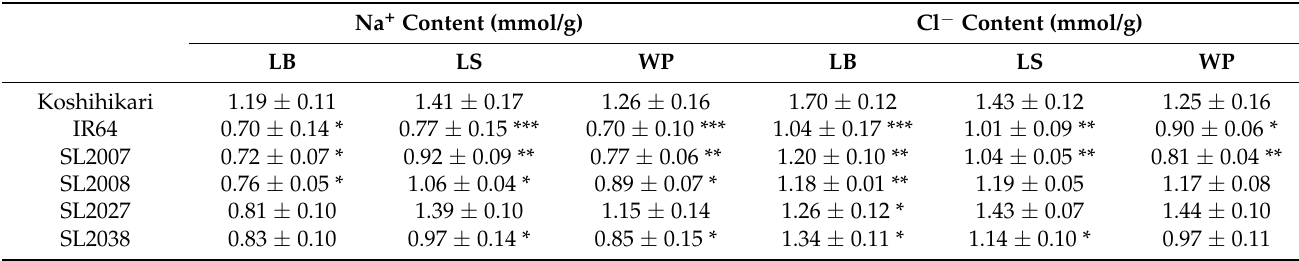
Figure 4. ( A ) Plant dry weight, ( B ) panicle weight, ( C ) panicle number, ( D ) grain yield, ( E ) spikelet number per panicle, ( F ) grain filling, and ( G ) 1000-grain weight of SL2007, SL2008, SL2027, SL2038, Koshihikari, and IR64 under non-stress and stress conditions in 2015. White bars and black bars denote plant performance under non-stress and stress conditions, respectively. Values are mean ± standard error (n = 4). *, **, and *** indicate significant differences from Koshihikari under the non-stress or salt stress condition at the 5%, 1%, and 0.1% levels by Dunnett’s test, respectively. Table 1. Na + and Cl − contents in the leaf blade, leaf sheath, and whole plant at the full heading stage of Koshihikari, IR64, and selected CSSLs under salt stress conditions in 2015. Values are mean ± standard error (n = 4). *, **, and *** indicate a significant differences from Koshihikari at the 5%, 1%, and 0.1% levels by Dunnett’s test, respectively. Na + Content (mmol/g) Cl − Content